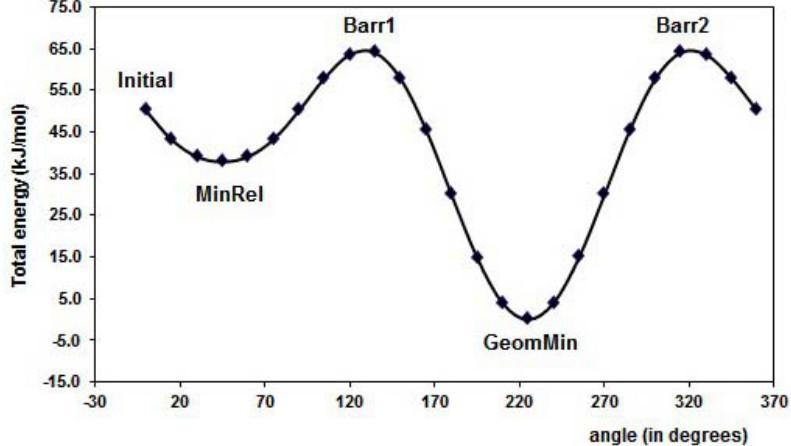
Figure 4. Graphical representation of the PES for 4-vinylpyridine, 4VPy, for the